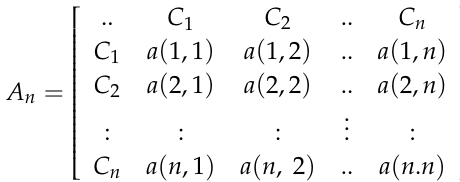
Failure occurs when multiple components Parallel connection fail simultaneously.